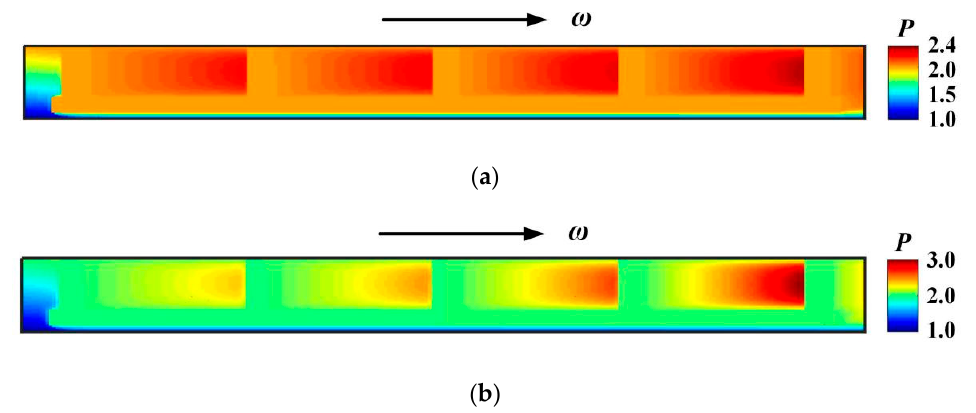
Figure 7. Pressure distribution at different deflection angles. ( p i = 0.2 MPa, ω = 3.2 × 10 4 r/min, T in = 580 K, T out = 380 K). ( a ) β = 6×10 − 6 rad; ( b ) β = 20×10 − 6 rad.